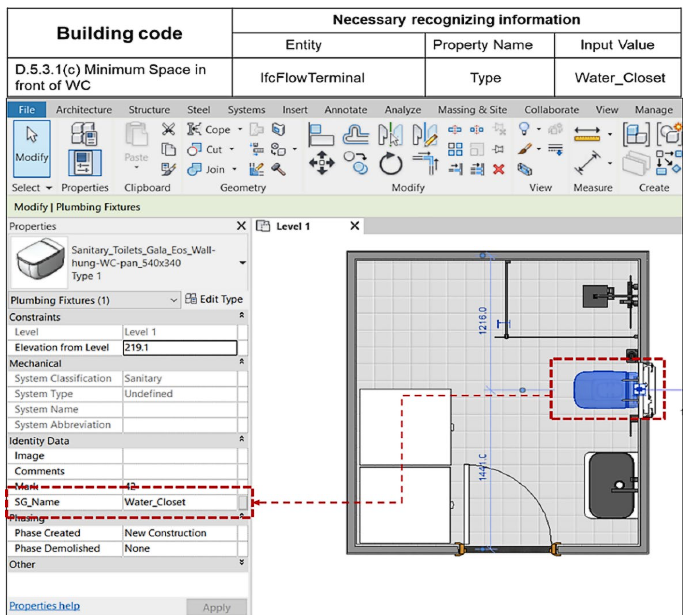
Figure 7. Example of specifying “Water_Closet” under SG_Name